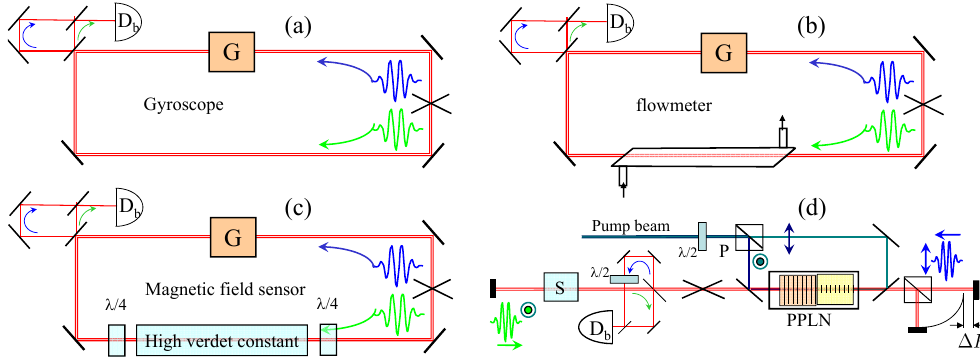
Figure 3. Examples of sensors based on active interferometry. ( a ) The laser gyroscope; ( b ) flowmeter application [8]; ( c ) magnetometer [9]; ( d ) linear configuration: the gain is provided by two orthogonal PPLN. P = polarizing beam splitter. The signal to be detected can be from a sample S of unknown dichroism or a length imbalance ∆ P of an end-cavity